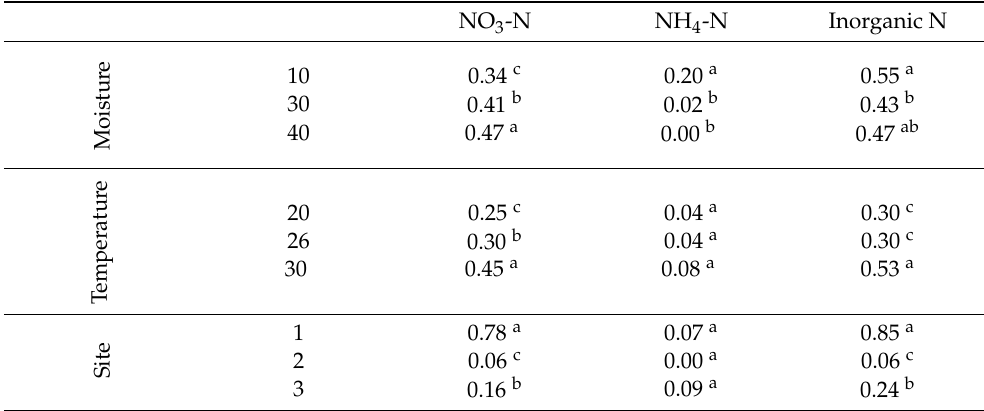
Table 3. Results of controlled N mineralization incubation. Vales are in ppm N per week, with connecting letters resulting from Tukey HSD